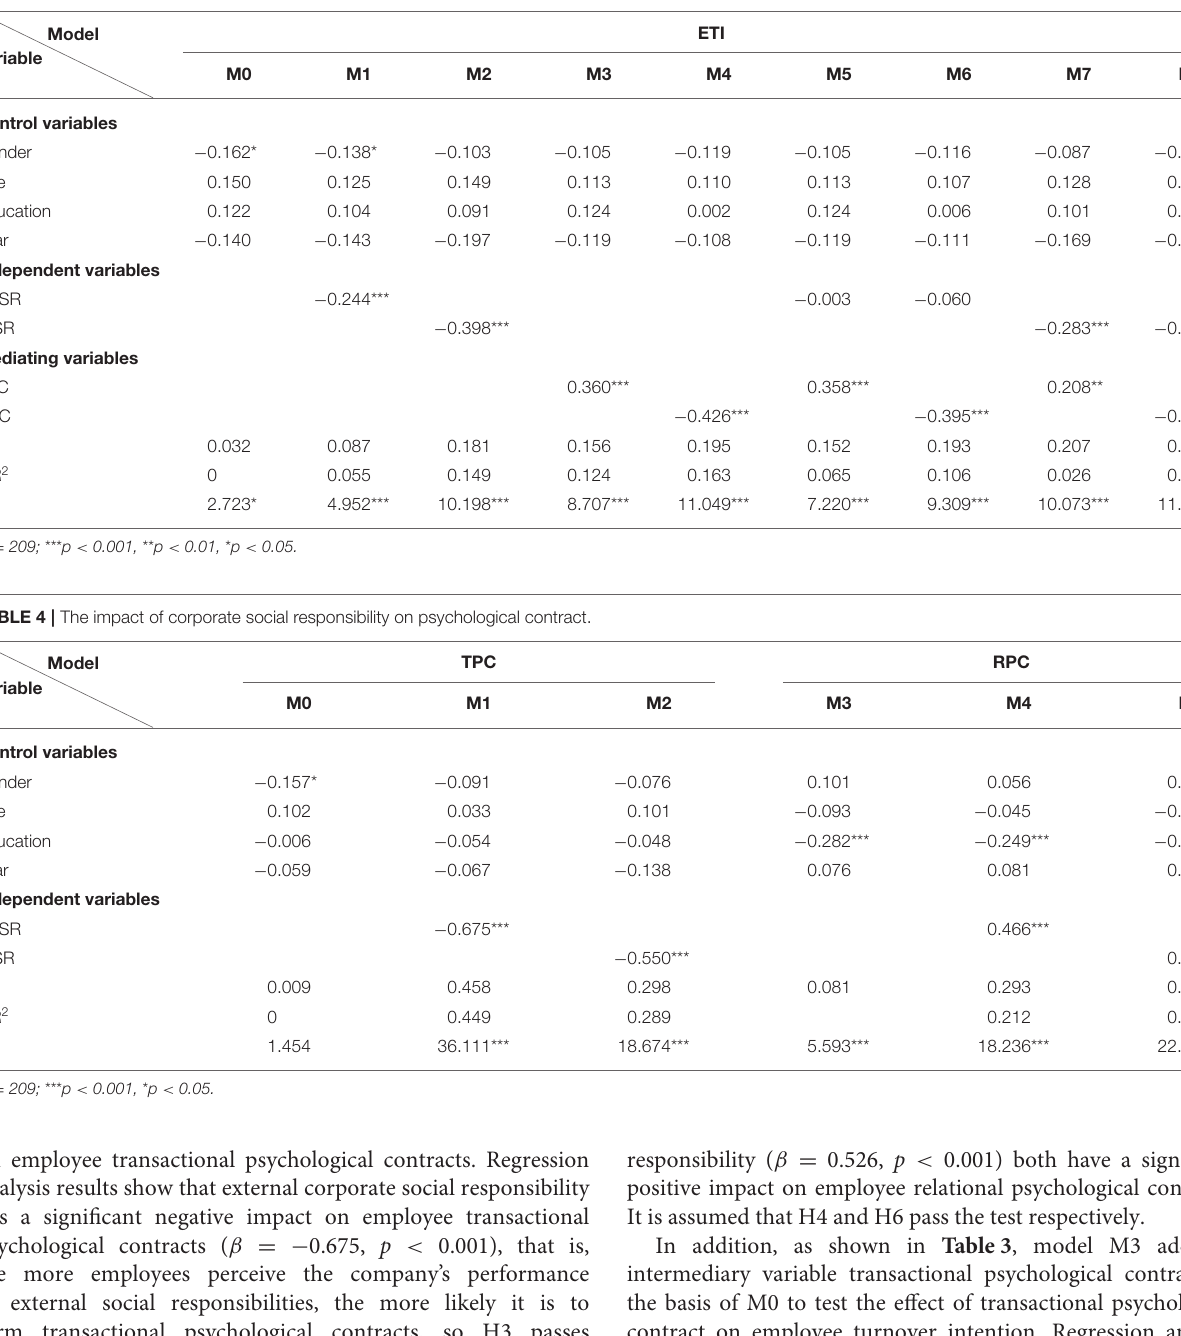
TABLE 3 | The impact of corporate social responsibility on employee turnover intention. Model Variable